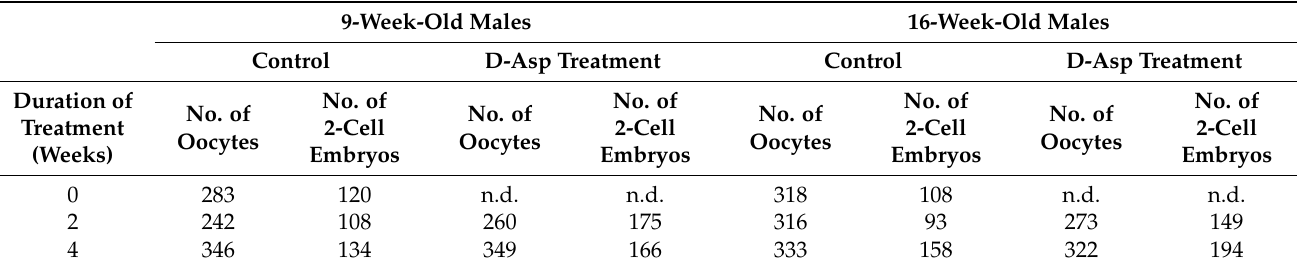
Table 1. The number of oocytes used and 2-cell embryos obtained with spermatozoa from 9-week-old and 16-week-old